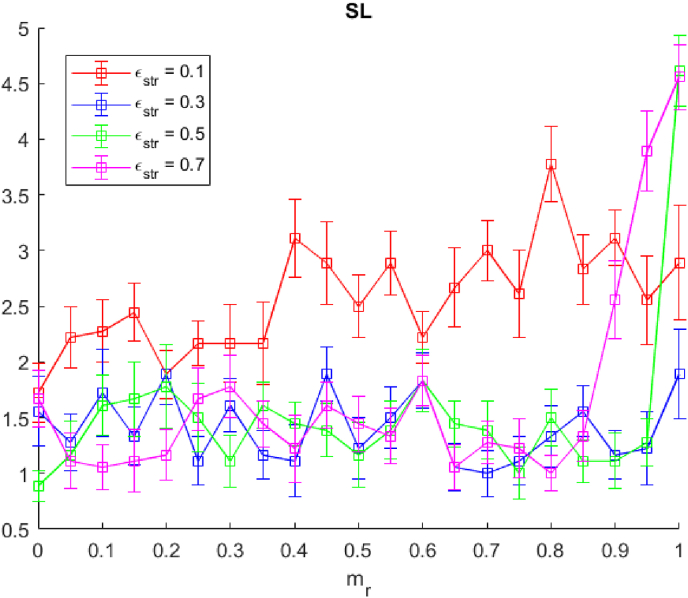
Set Loss Errors as a function of mr, for four different values of εstr. Error bars show one standard error from the mean.